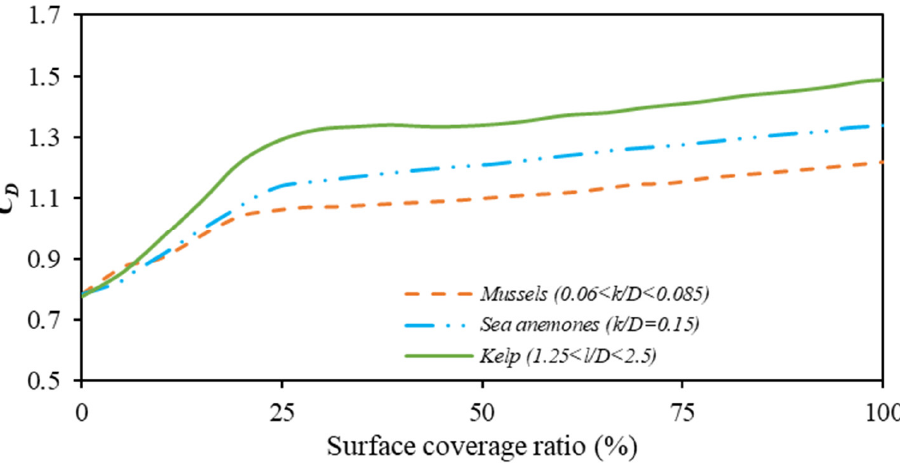
Figure 9. Evolution of drag coefficient ( C D ) as a function of biofouling coverage ratio for different surface roughness values ( k ) and biofouling type (adapted from [31]).